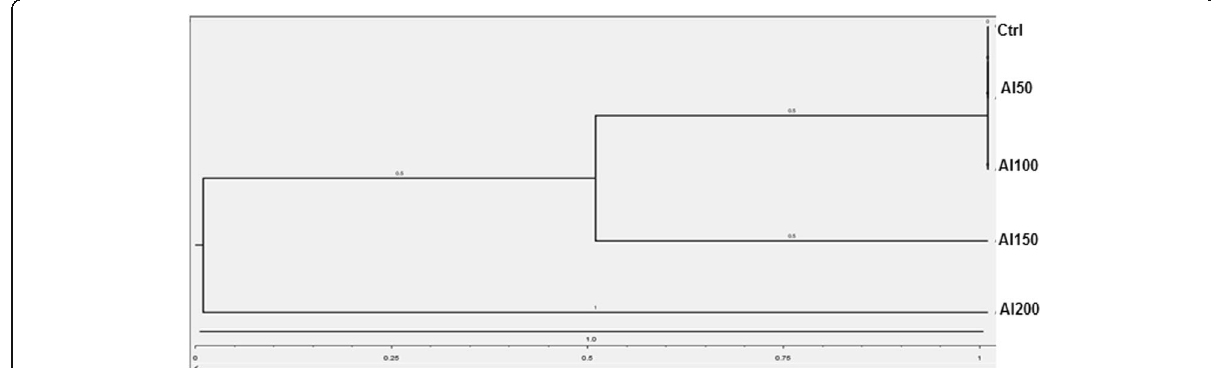
Fig. 5 Dendrograms generated by UPGMA cluster method based on Protein SDS-PAGE electrophoresis Ctrl: Control, Al50: Al at 50 mg/L -1 , Aa100: Al at mg/L -1 , Al150: Al at 150 mg/L -1 , Al200: Al at 200 mg/L